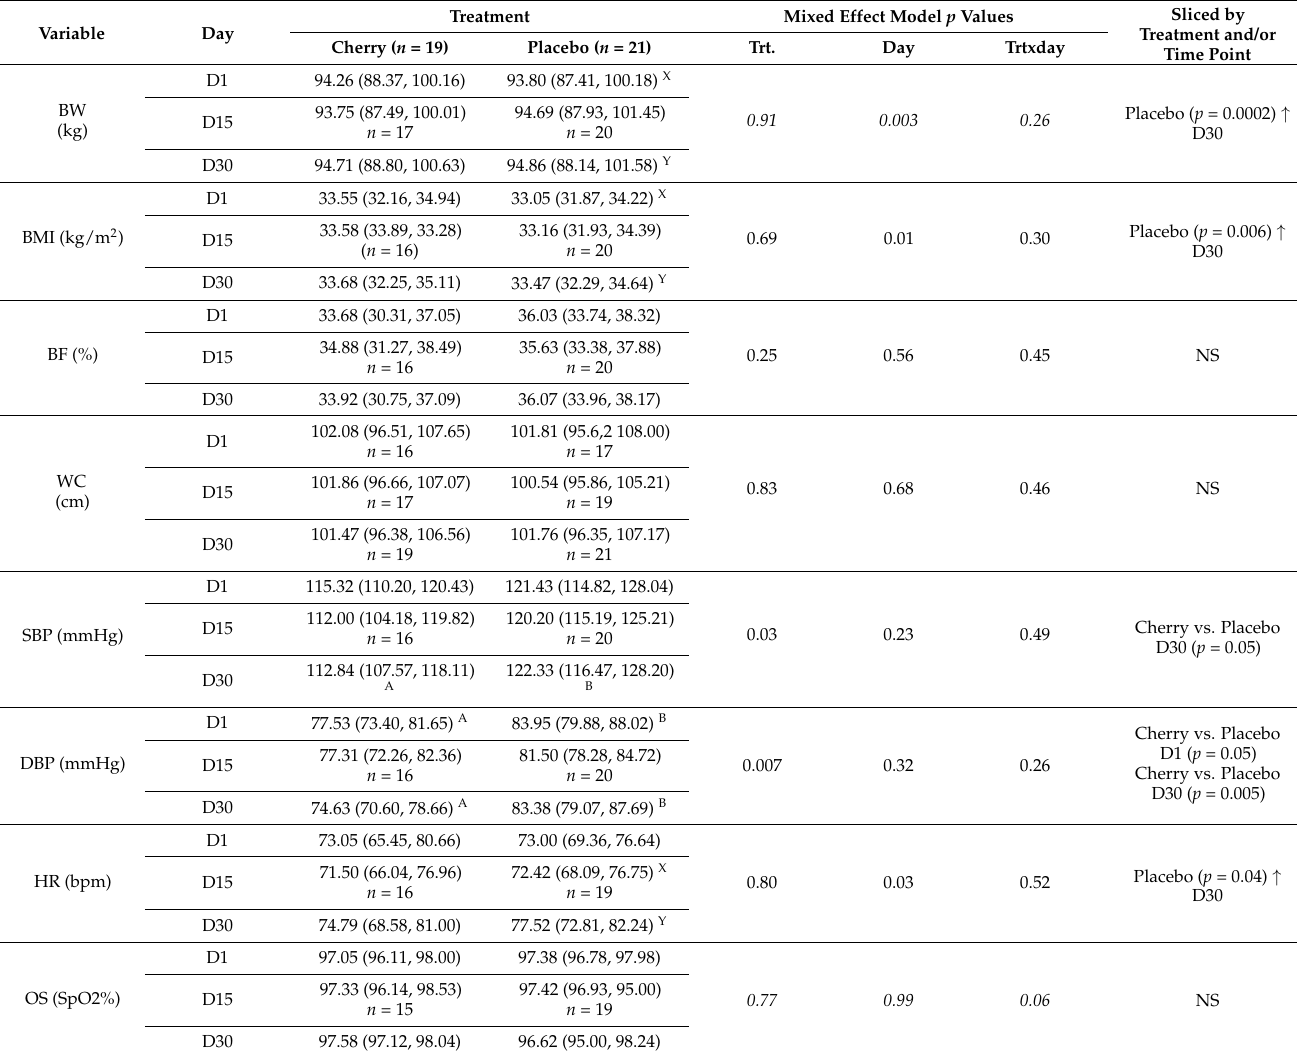
Table 1. Anthropometric and physiological parameters in cherry and placebo